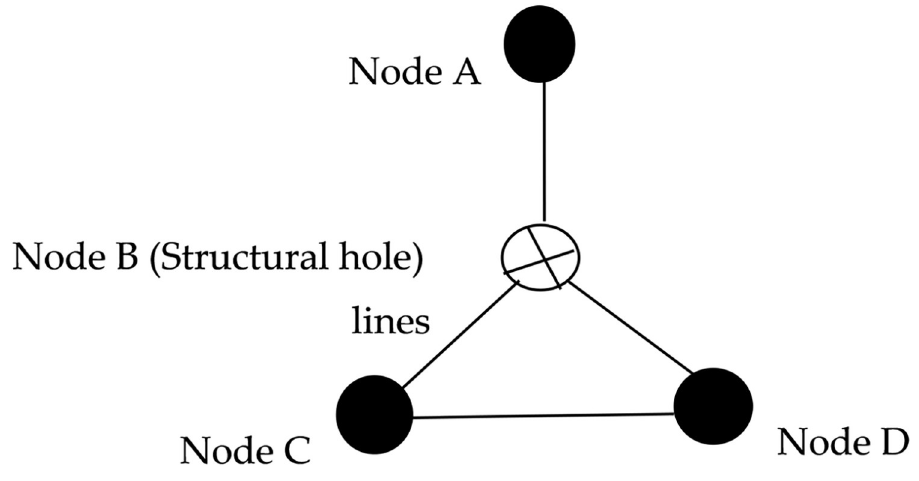
Fig 2. Structural hole